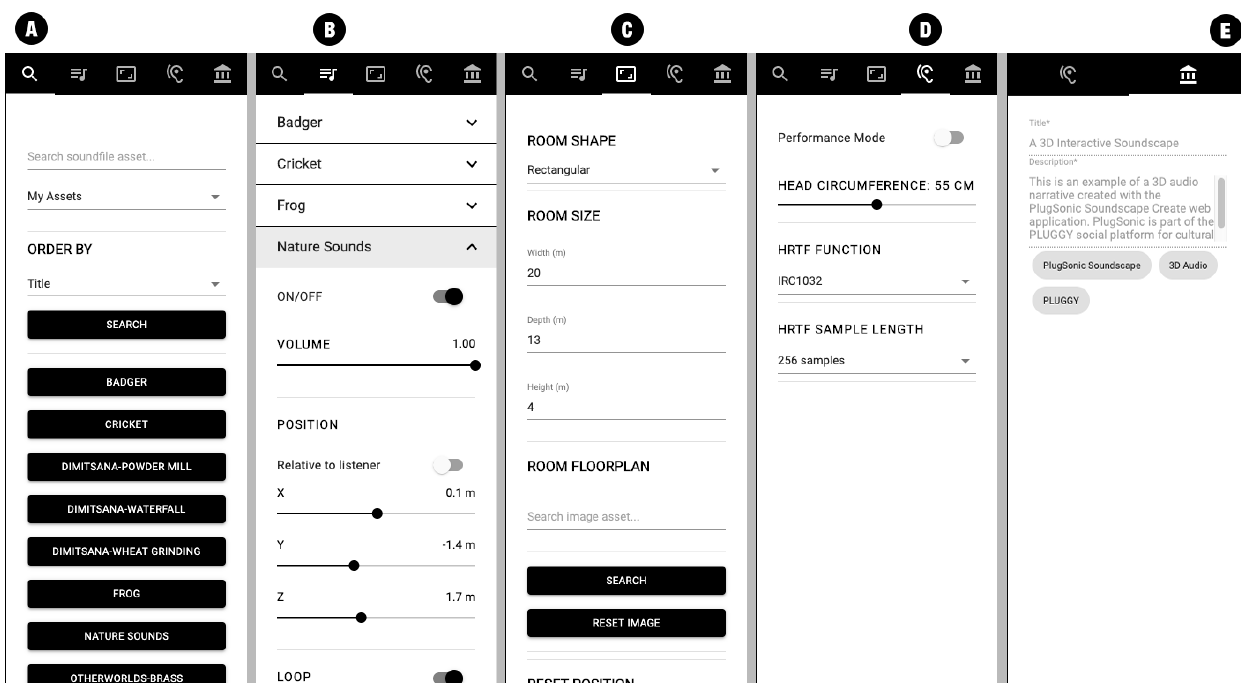
Figure 3. PlugSonic Soundscape Create dismissable menus: ( A ) Sound source search tab, ( B ) Sound sources settings tab, ( C ) Room settings tab, ( D ) Listener settings tab, ( E ) Exhibition